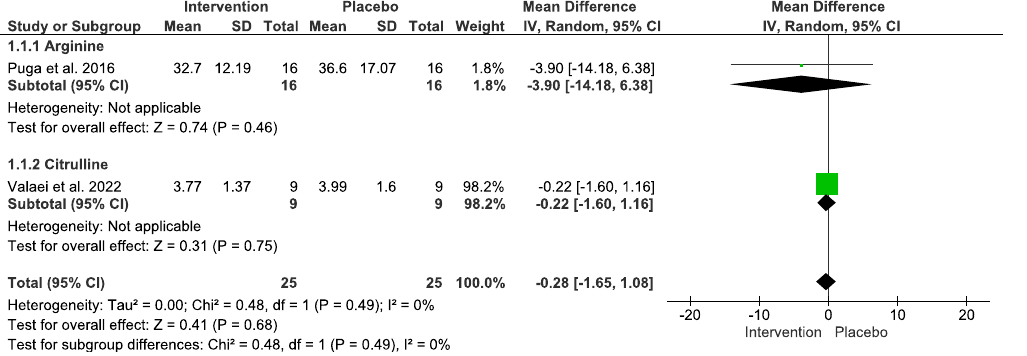
Figure 5. Effects of L-Arginine on inflammatory markers . 3.8. Anti-Inflammatory Markers No difference was detected. In the “Test for overall effect,” we revealed a subtotal = − 0.38 [ − 1.15, 0.39], p = 0.34 and heterogeneity = 15%. Testing for subgroup differences was not applicable (Figure 6). The GRADE quality of evidence for this result was very low (Table 2). We performed a sensitivity analysis to assess each study’s influence on the heteroge- neity. In this analysis, the withdrawal of specific studies did not affect the total result of the meta-analysis (see sensitivity analysis in Supplementary Material). A funnel plot and meta-regression were not applied due to the small number of studies included. We con- sulted the Cochrane Handbook [24].